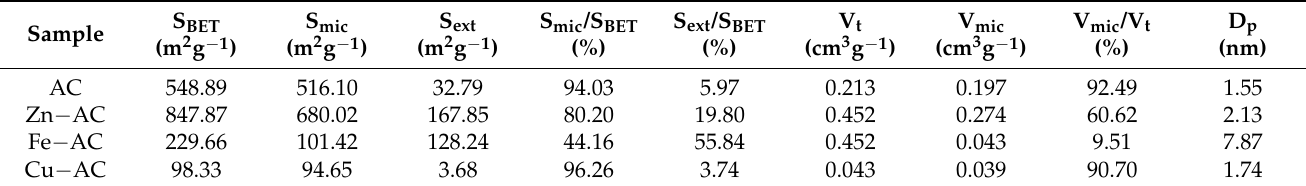
Table 1. Textural properties of activated carbon derived from WPTs.